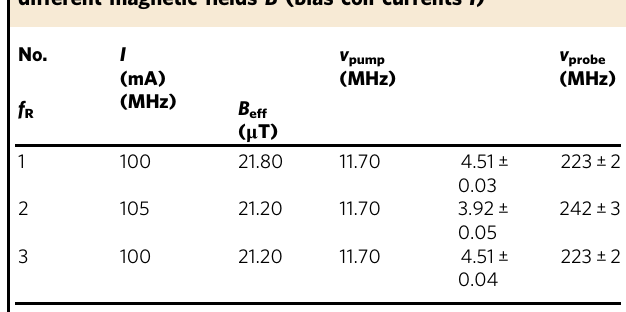
Table 2 FFT frequency of the Ramsey fringes f R in 6H- 28 SiC for different pump v pump and probe v probe frequencies